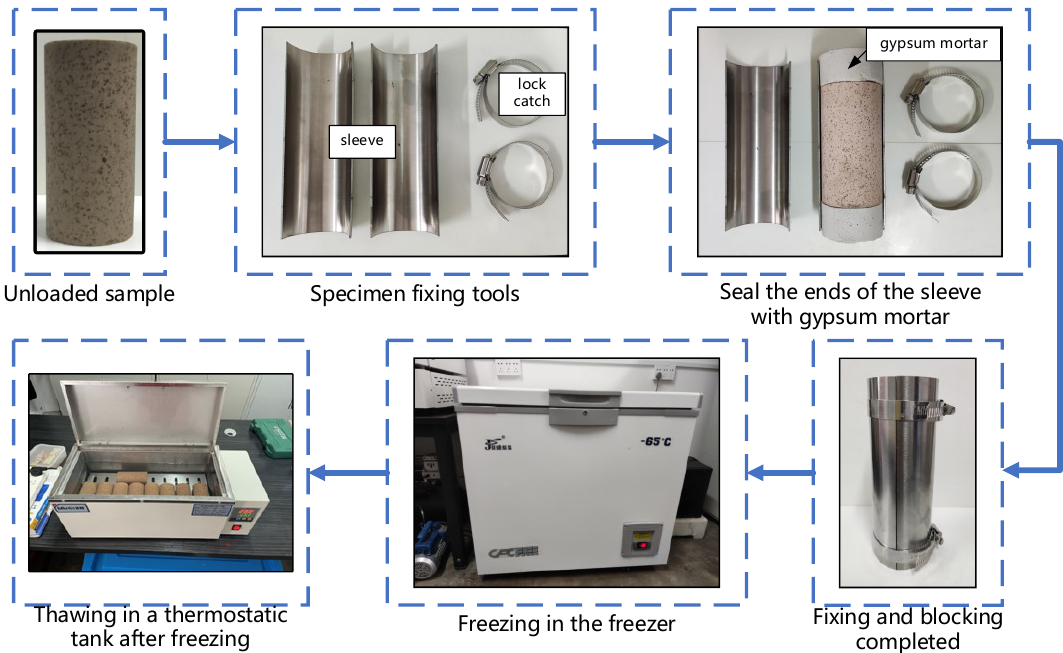
Figure 4. Freeze – thaw test procedure. Figure 4. Freeze–thaw test